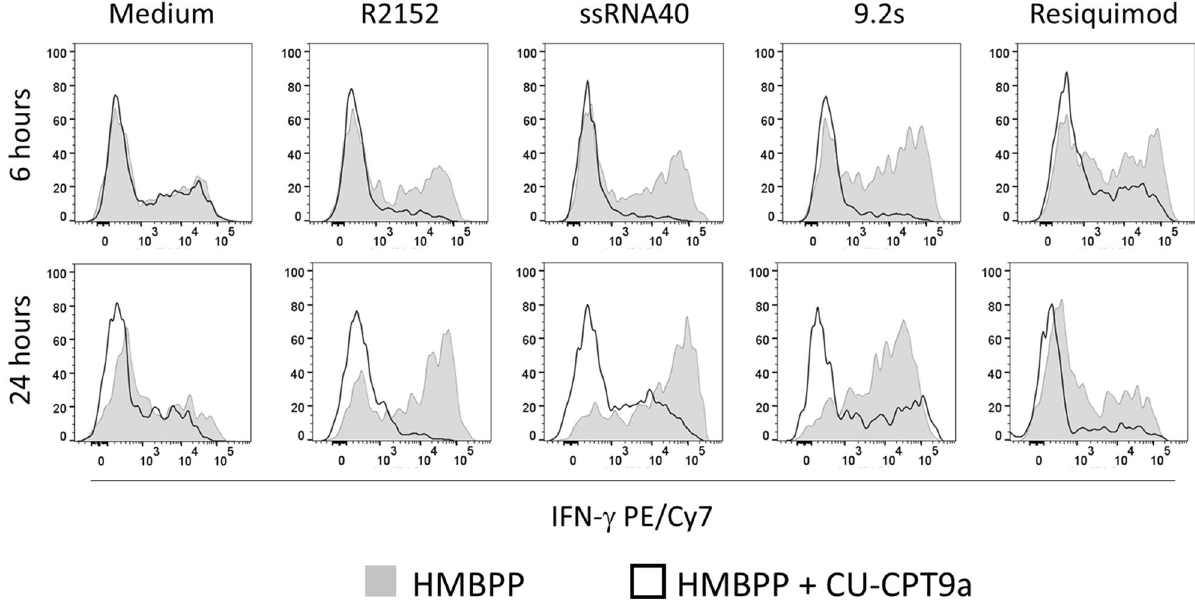
Figure 3. Co-stimulation by RNA ligands is TLR8-dependent. PBMC were activated with HMBPP in the presence or absence of TLR8 ligands and additional presence or absence of 10 µM TLR8 inhibitor CU-CPT9a. Intracellular expression of IFN-γ in CD3 + Vδ2 + γδ T cells was analyzed after 6 (upper panel) and 24 h (lower panel). Gray histograms: without CU-CPT9a, open histograms: with CU-CPT9a. One out of two experiments with similar results is